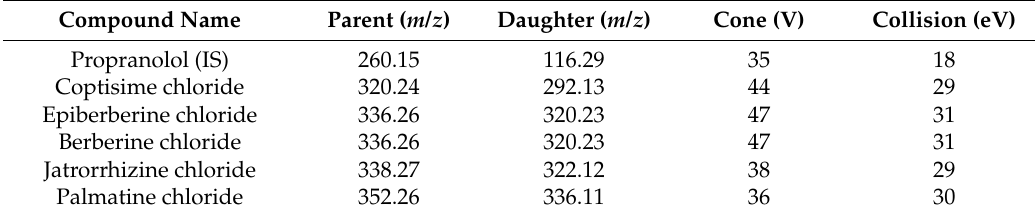
Table 1. The optimized mass spectrometry (MS) parameters of the five alkaloids and internal standard